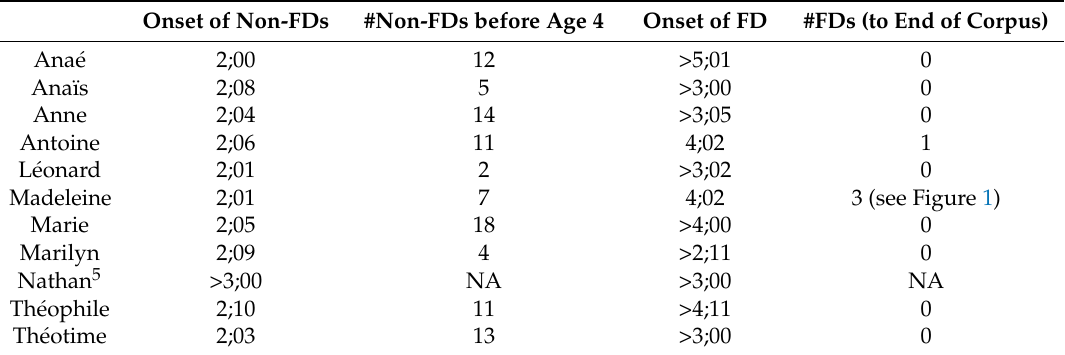
Table 2. Results by